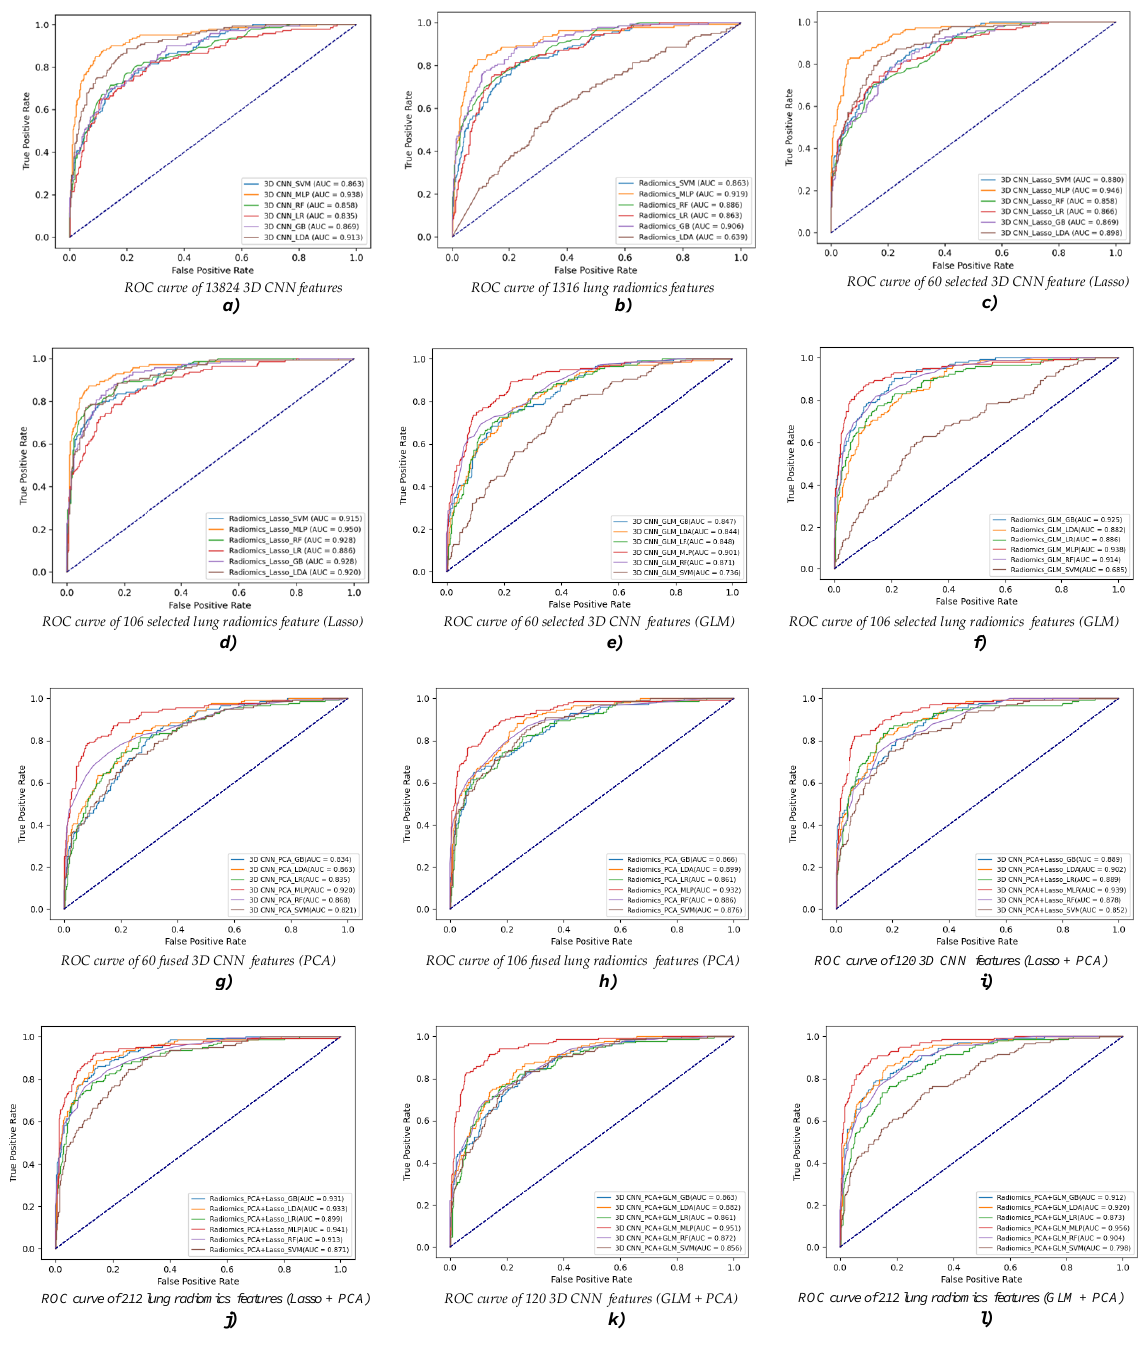
Figure 5. Visual ROC curves of different ML classifiers with different features in Experiment 1. ( a,b ) The ROC curves of different ML classifiers with 13,824 original 3D CNN/1316 original lung radiomics features. ( c – h ) The ROC curves of different ML classifiers with 60 3D CNN/106 lung radiomics features separately selected or fused by the Lasso algorithm, GLM, and PCA algorithm. ( i – l ) The ROC curves of different ML classifiers with different combinations of feature vectors of the selected and fused lung radiomics features or the selected and fused 3D CNN features.